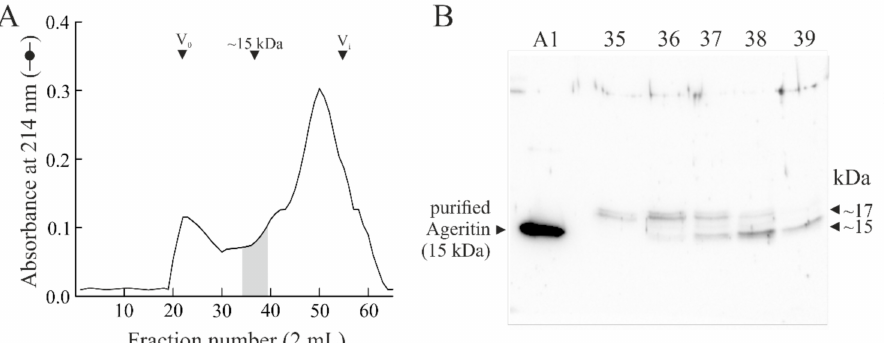
Figure 4. ( A ) Elution profile from the gel-filtration chromatography on a HiLoad 16 / 60 Superdex 75 column obtained for mycelium basic proteins. V 0 and V i , void and included volumes, respectively. ( B ) Western blot analysis of fractions with an elution volume about 15-kDa (highlighted in grey). 0.5 µ g of proteins eluted in fraction 35, 36, 37, 38, and 39 was loaded in respective lanes. Fractions aliquots were separated by SDS-PAGE with β -mercaptoethanol and subjected to Western blot analysis using rabbit antiserum against Ageritin. SDS-PAGE was carried out in 15% polyacrylamide separating gel. A1 and A2, 100 and 50 ng of Ageritin as control [1],